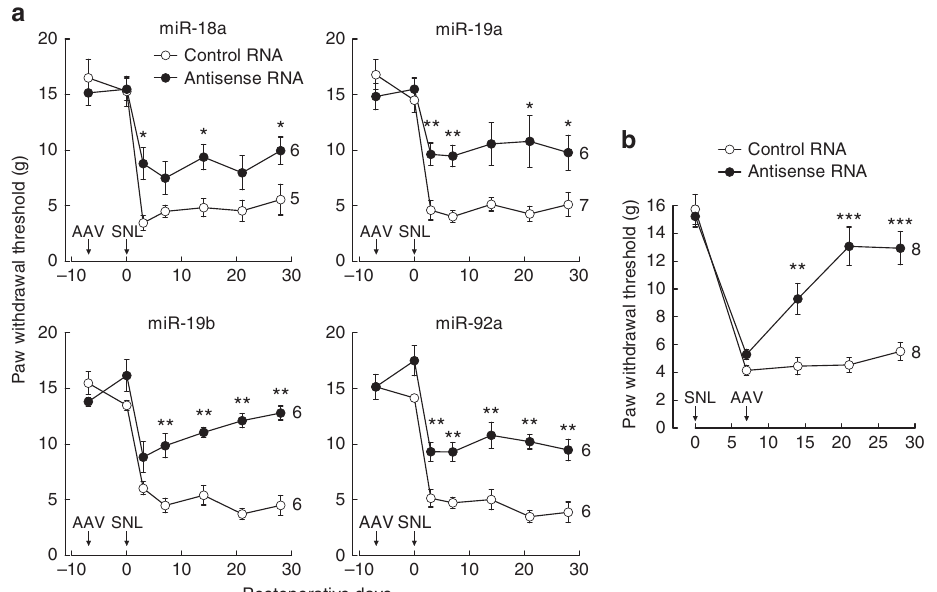
Figure 3 | Blockade of miR-17-92 cluster members suppresses mechanical allodynia in SNL. Paw withdrawal responses to mechanical stimuli were evaluated on the AAV-injected/SNL side. Numbers of animals are indicated to the right of the plots. ( a ) AAV vector encoding control TuD antisense RNA or TuD antisense RNA against each miR-17-92 cluster member was administered to the L5 DRG 7 days before SNL (indicated by arrows). ( b ) Mixture of AAV vectors encoding TuD antisense RNAs against miR-18a, miR-19a, miR-19b and miR-92a was administered to the L5 DRG 7 days after SNL (indicated by arrows). Error bars are s.e.m. * P o 0.05, ** P o 0.01 and *** P o 0.001 (miR-18a, P ¼ 0.011 for 3d, P ¼ 0.030 for 14d and P ¼ 0.030 for 28d; miR-19a, P ¼ 0.008 for 3d, P ¼ 0.002 for 7d; P ¼ 0.014 for 21d and P ¼ 0.035 for 28d; miR-19b, P ¼ 0.004 for 7d, P ¼ 0.002 for 14d, P ¼ 0.002 for 21d and P ¼ 0.002 for 28d; miR-92a, P ¼ 0.002 for 3d, P ¼ 0.002 for 7d, P ¼ 0.009 for 14d, P ¼ 0.002 for 21d and P ¼ 0.004 for 28d; antisense RNA mixture, P ¼ 0.003 for 14d, P o 0.001 for 21d and P o 0.001 for 28d) compared with the control injection, Mann–Whitney U